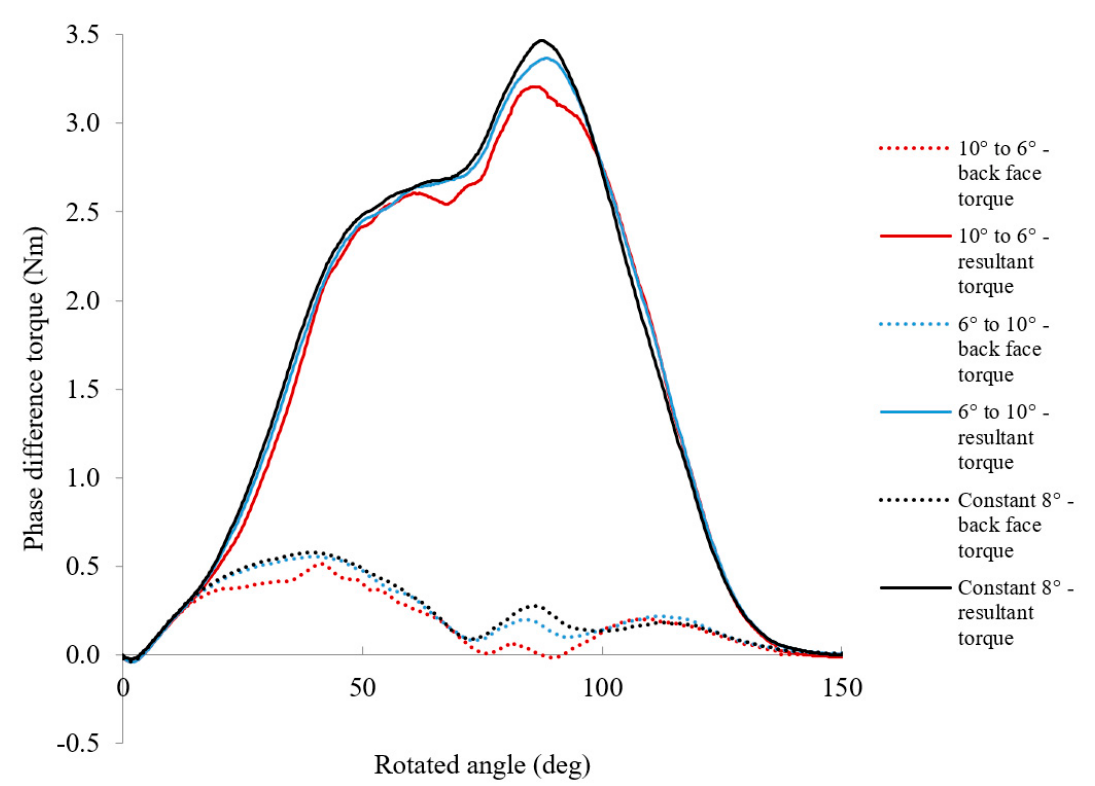
Figure 19. Resultant torque and back face torque against rotated angle for three variations of the “low interference” blade.